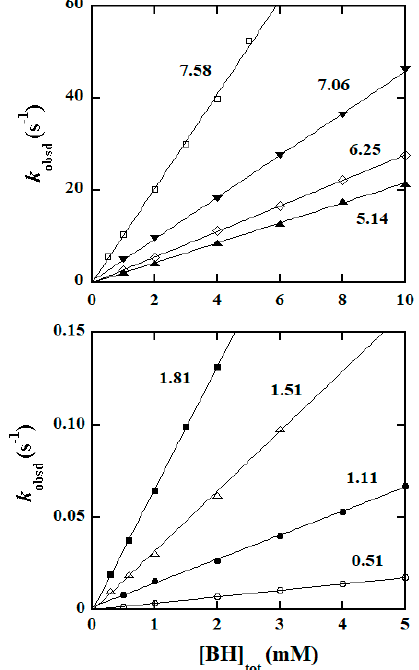
Figure 2. Plots of k obsd versus [BH] tot at 25.0 °C and different pHs with the numbers around the lines indicating the pH values.